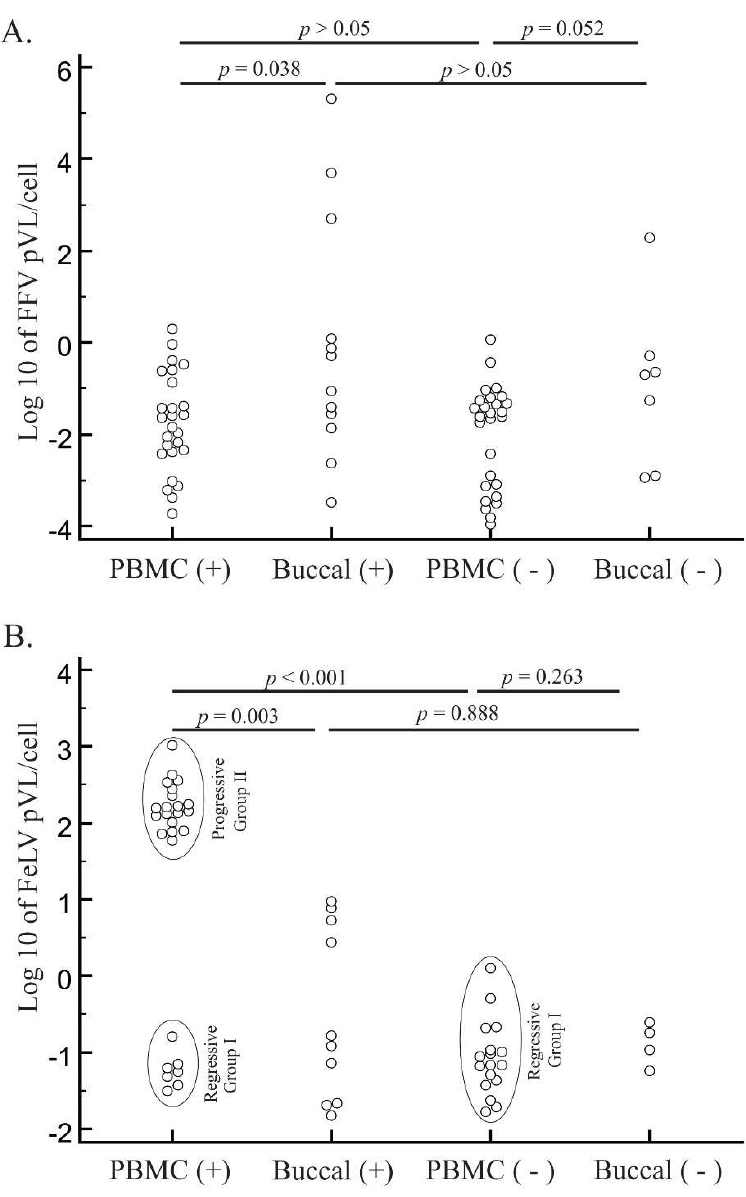
Figure 1. Distribution of feline foamy virus (FFV) and feline leukemia virus (FeLV) log10 proviral loads (pVLs) in blood and oral specimens. FFV ( A ) and FeLV (B) pVLs were measured by quantitative PCR of specimens with nested PCR-positive and -negative test results from domestic cats from Brazil. PCR-positive and -negative cat samples in peripheral blood mononuclear cell (PBMC) or buccal specimens are presented on the x -axis. Horizontal lines above each graph depict statistical comparisons between the pVL of specific animal groups or specimen types (Student’s t tests) with associated probability ( p ) values shown. Ellipses in ( B ) represent different cat groups of FeLV infection outcomes (regressive or progressive).